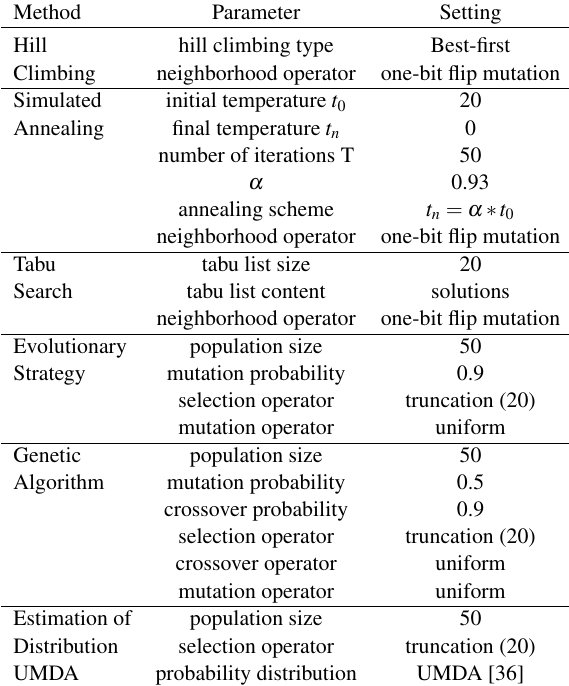
Table 3. Methods that integrate the algorithm portfolio